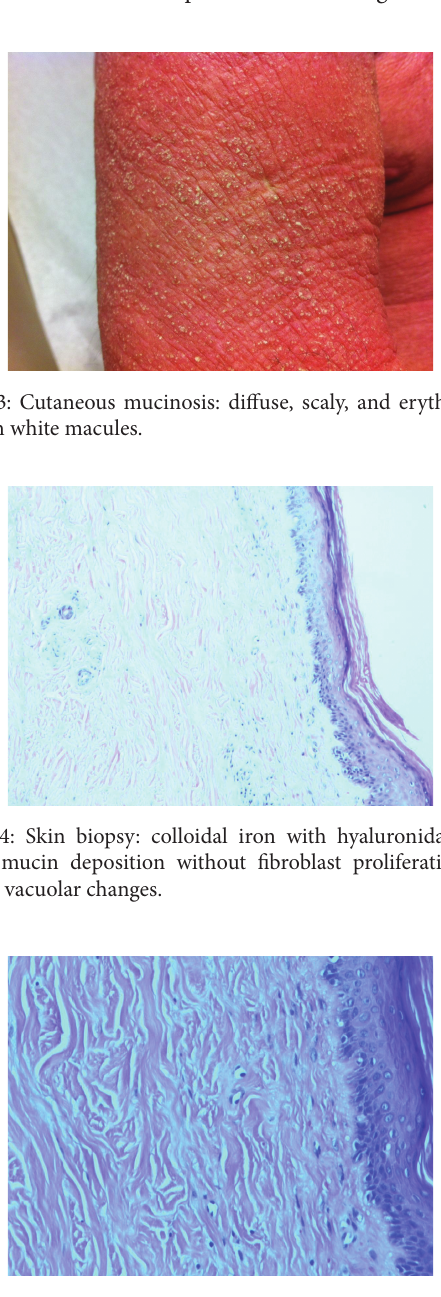
Figure 5: Skin biopsy: colloidal iron × 200: dermal mucin deposi- tions without fibroblast